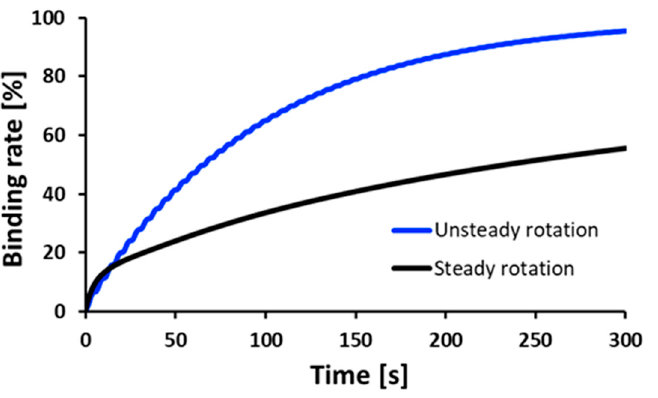
Figure 10. Calculated increase in the binding rate for stop and re-rotation compared to steady rotation conditions.